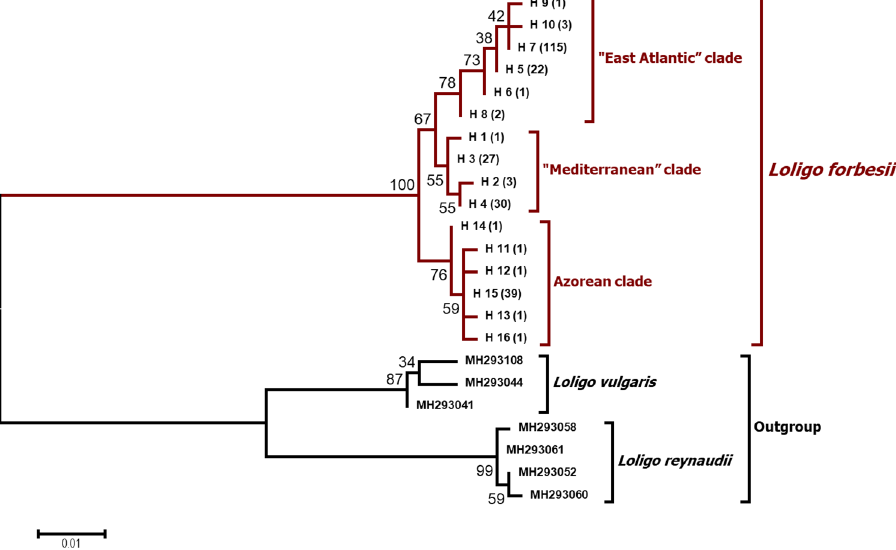
Figure 5. Molecular phylogenetic analysis after Maximum Likelihood (ML) method (1000 Bootstraps). Labelling next to the species names indicate the GenBank Accession Numbers for L. reynaudii and L. vulgaris